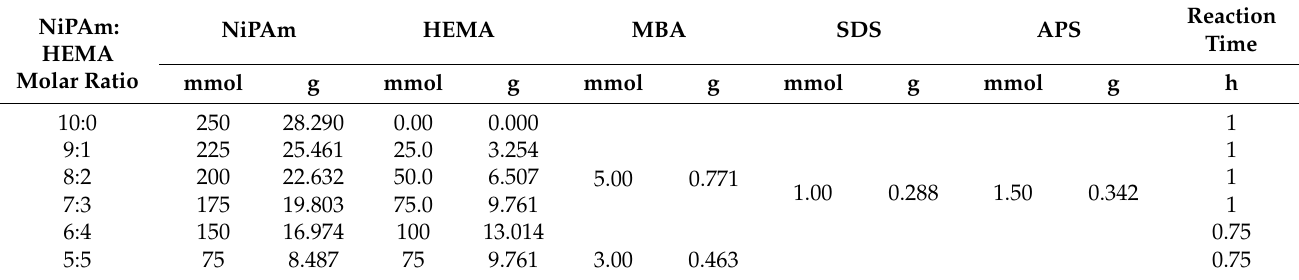
Table 1. Reaction recipe for the synthesis of poly(N-isopropylacrylamide-co-2-hydroxyethyl methacrylate) (p(NiPAm-co- HEMA))